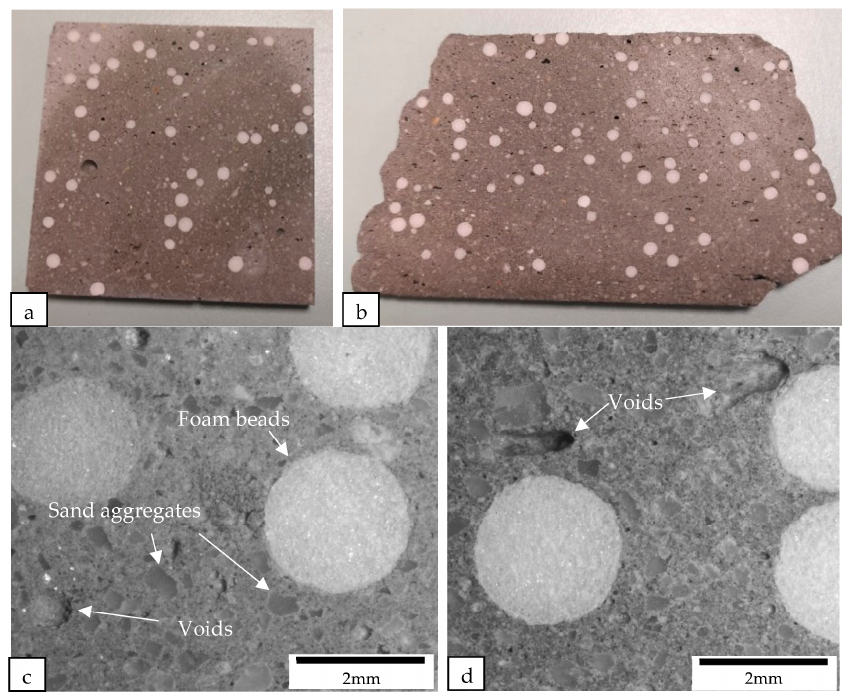
Figure 15. Cross-sectional images of ( a ) the cast and ( b ) the printed samples containing foam bead aggregate replacement were obtained using a camera, while the macrostructure of the cross sections of ( c ) the cast and ( d ) the printed samples containing foam bead aggregate replacement were examined under a microscope.